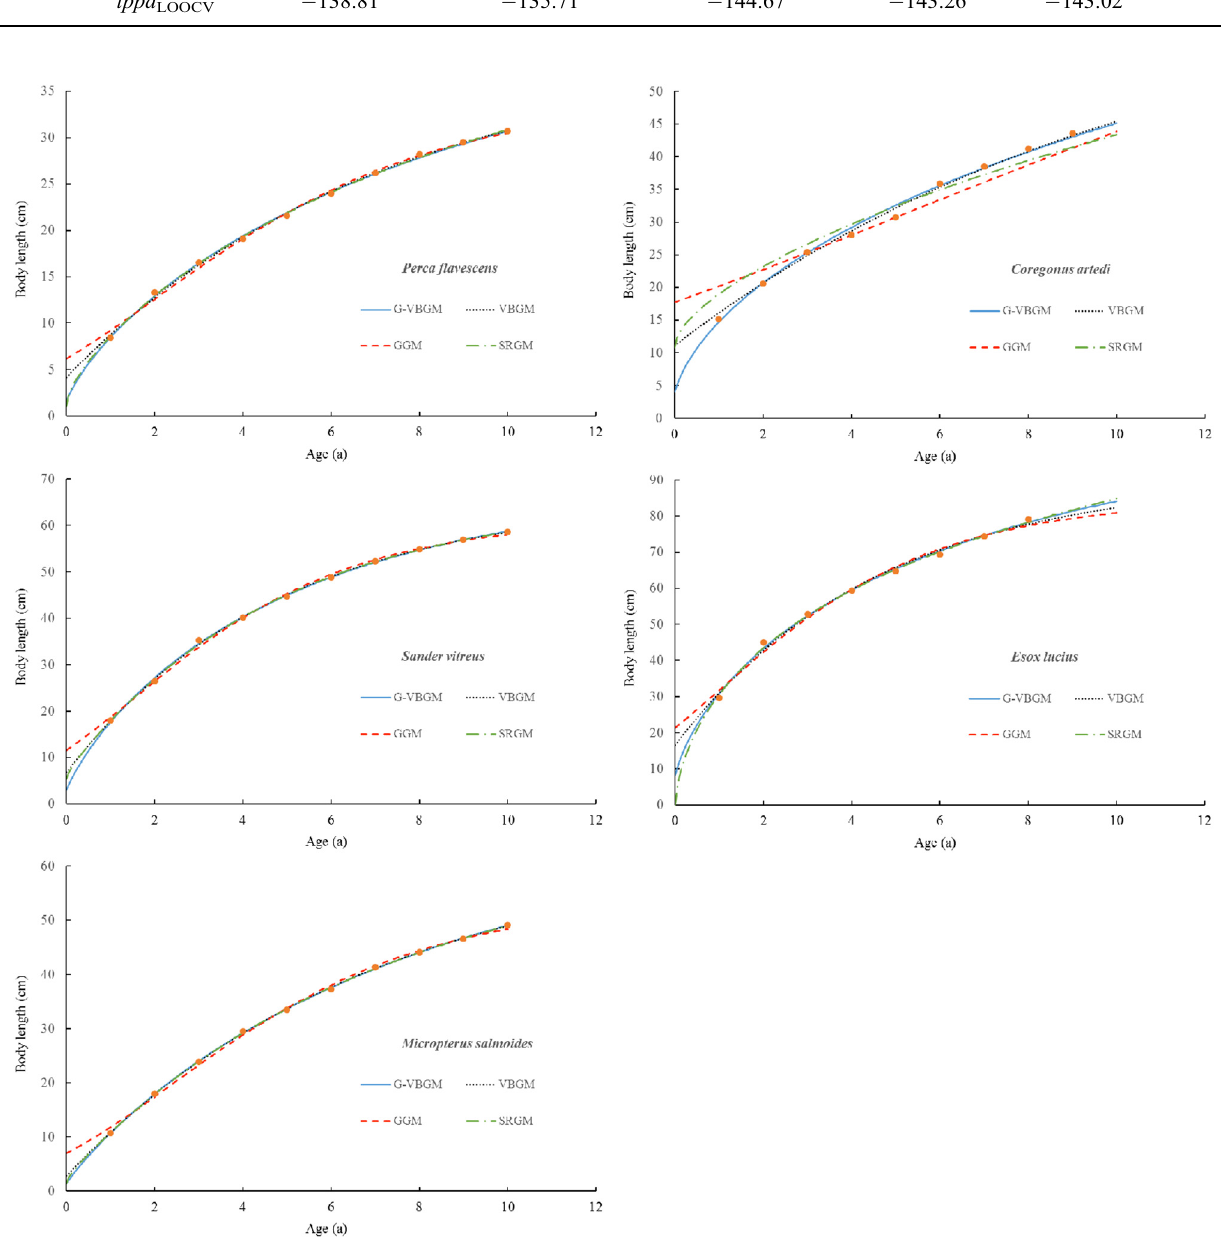
Fig. 2. Variations in leave-one-out (a) and smooth leave-one-out (b) errors as a function of log( l 2 ) for Micropterus salmoides